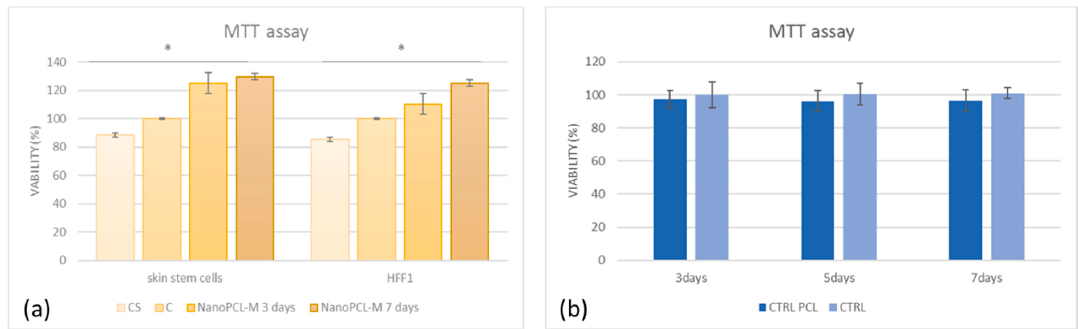
Figure 4. ( a ) The effect of NanoPCL-M on HFF1 fibroblasts and skin stem cells after three and seven days of pretreatment and then UV exposure. Graphs show the percentage of cellular metabolic activity as compared to negative control C (100%). CS represent cells untreated with NanoPCL-M and exposed to UV (stressed control), and C represents negative control. ( b ) effect of nanofiber in PCL (poly ε -caprolactone) (CTRL PCL) on stem cells compared with cells untreated (CTRL). Error bars represent standard deviation. * p value ≤ 0.05